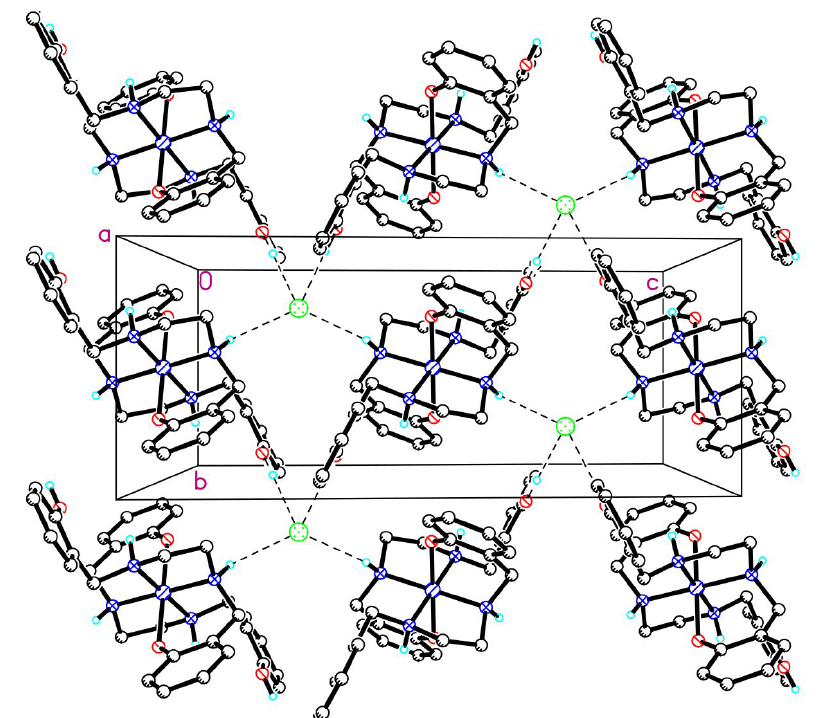
Fig. 2. Molecular packing structure of 1 . Hydrogen bonds are shown as dashed lines. In the crystal structure, the complex cations are linked by chloride anions through intermolecular hydro- gen bonds of types N–H∙∙∙Cl, N–H∙∙∙O and O–H∙∙∙Cl (Ta- ble 3), to form two-dimensional network along the bc plane (Fig.